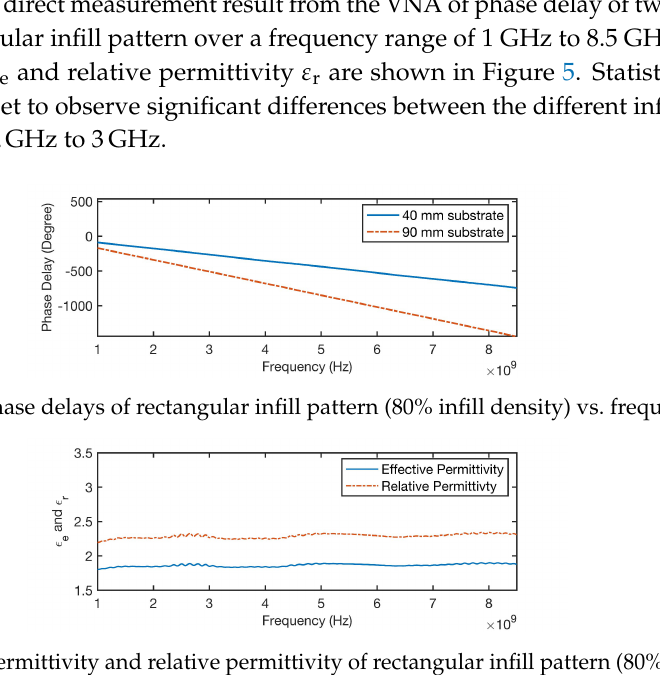
Figure 5. Effective permittivity and relative permittivity of rectangular infill pattern (80% infill density) vs.